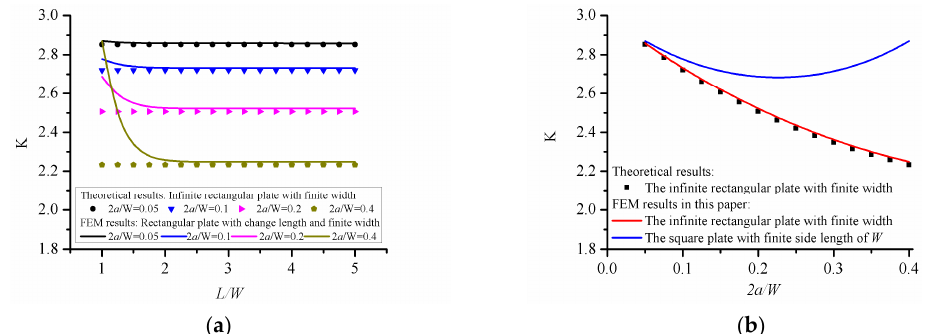
Figure 2. Variation of stress concentration factors for a central circular hole in a rectangular panel ( a ) rectangular panels with different lengths, ( b ) rectangular and square